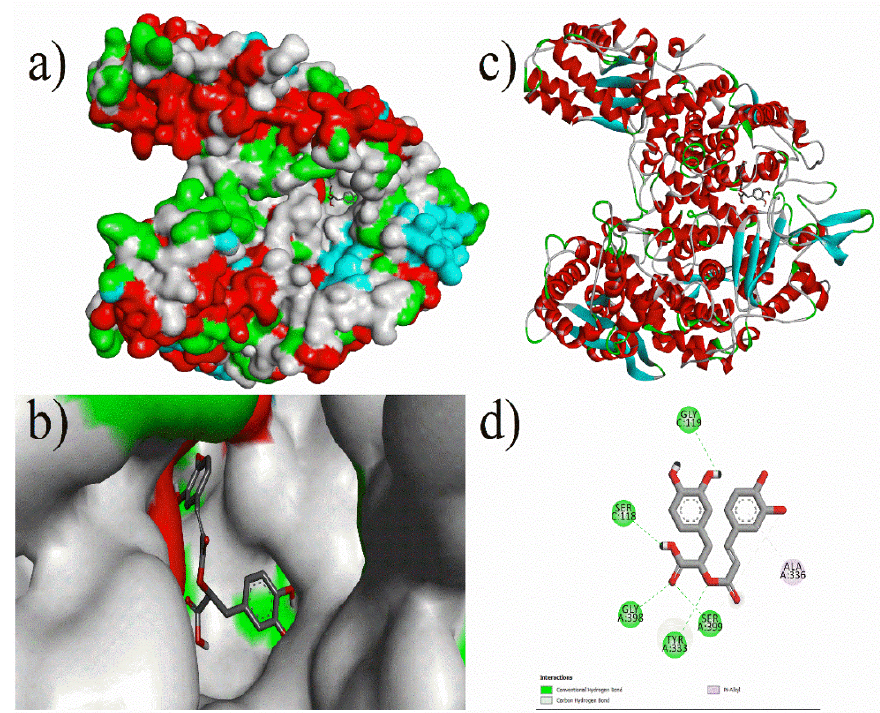
Figure 3. Molecular docking of Rosmarinic-acid with 5A8K protein: ( a ) Docking surface pocket pose, ( b ) docking interaction at surface, ( c ) 3D protein–ligand interactions, and ( d ) 3D interaction of protein amino acid residues with compound rosmarinic-acid.